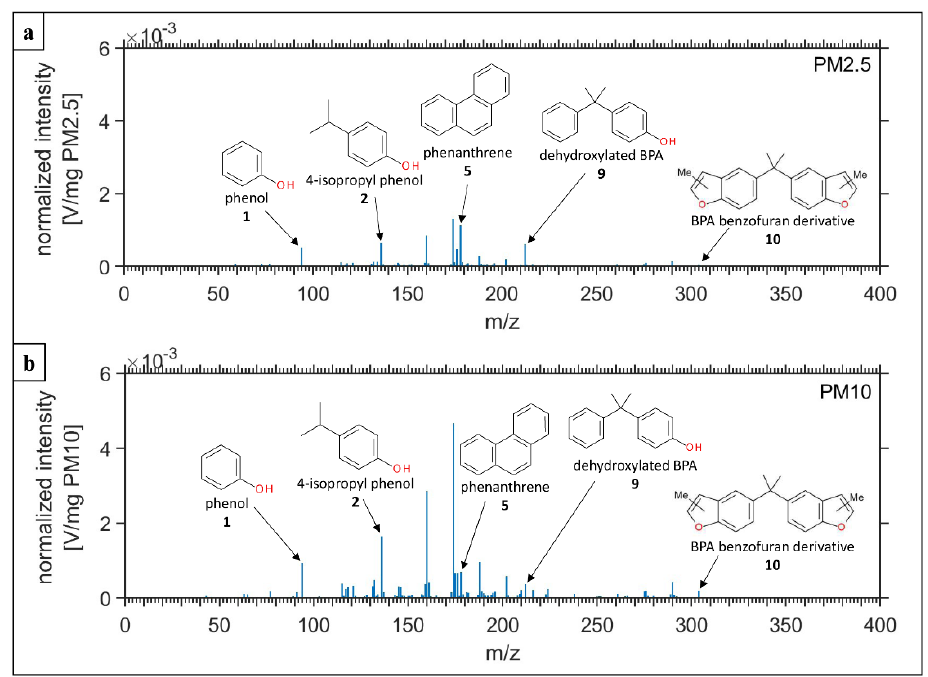
Figure 3. Averaged REMPI spectra (248 nm, 500 Hz) of thermal desorption OC fraction (20–280 °C, OC1 + OC2) of PM 2.5 ( a ) and PM 10 ( b ) formed during dry-cutting of C 3 exposed to 300 °C (air atmosphere, 3 h).